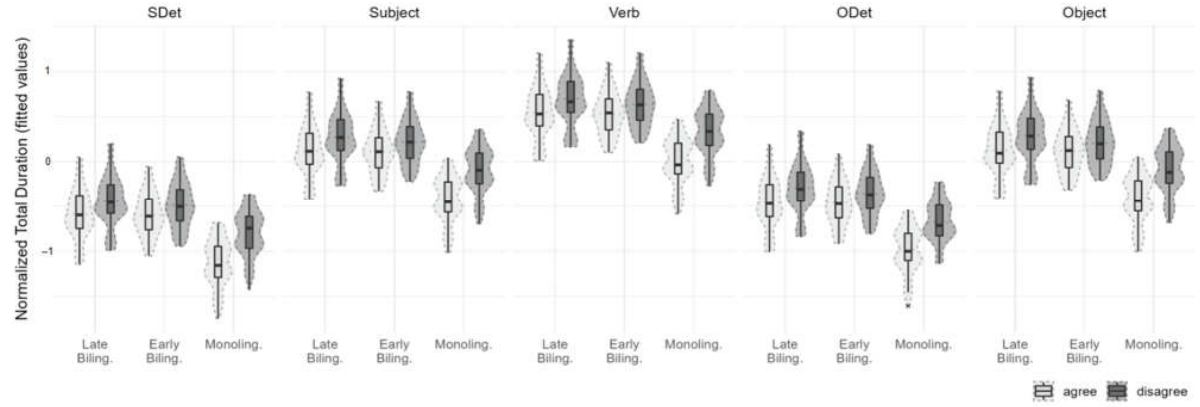
Figure 3. Normalized total time duration means (fitted values from statistical models). Reading data with monolinguals.